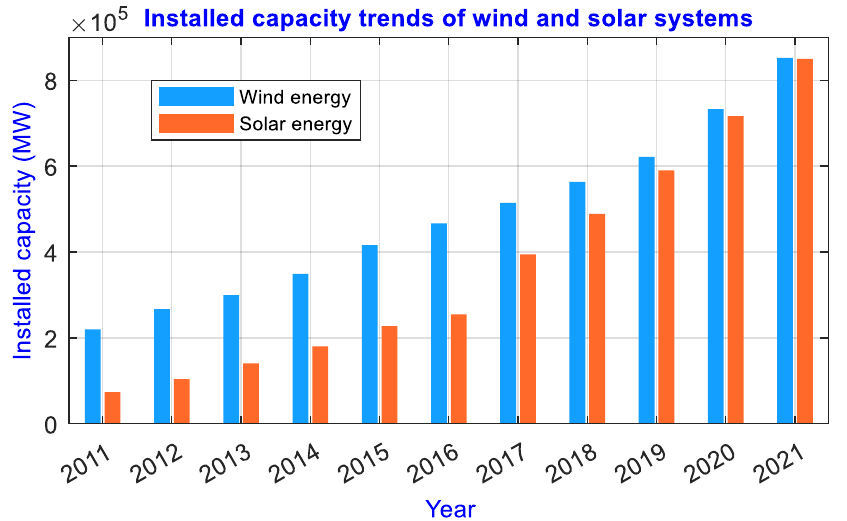
Figure 1. Installed capacity of wind and solar energies during the last ten years (2011 – 2021).